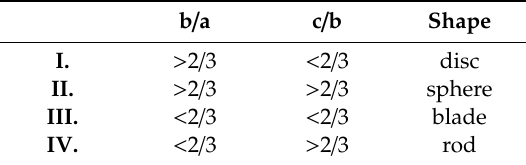
Table 2. Basic types of pebble shapes, after [28].